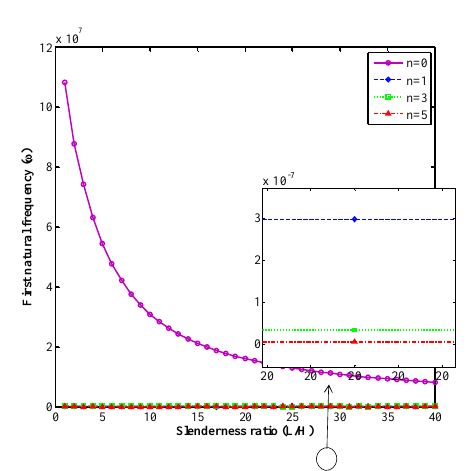
Fig. 4. The influence of nonlocal parameter on the natural frequency.